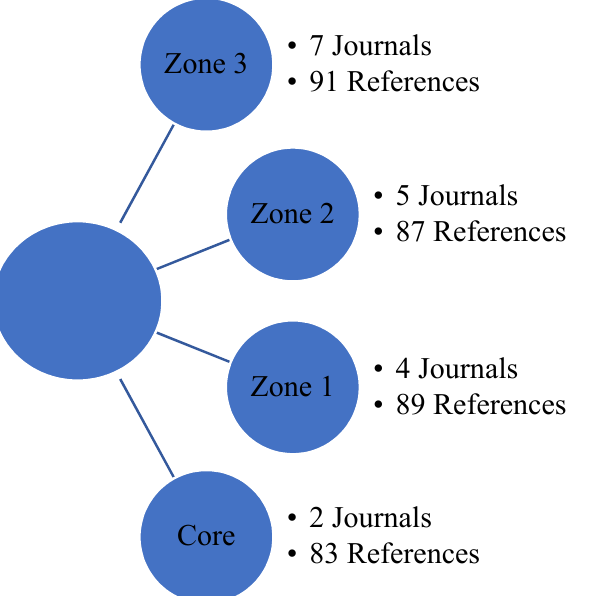
Figure 5. Dispersion of the scientific production indexed in the WoS and Scopus databases. Both variables are correlated in the opposite direction, with a linear correlation of perfect negative slope between both variables (number of articles and number of journals). The Pearson correlation coefficient in the Web of Science database is r = − 0.747 and in Scopus r = − 0.991 (Figure 6).